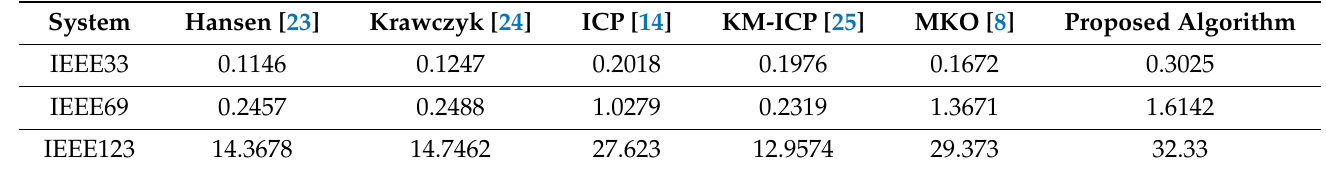
Table 3. The calculation efficiency for the three